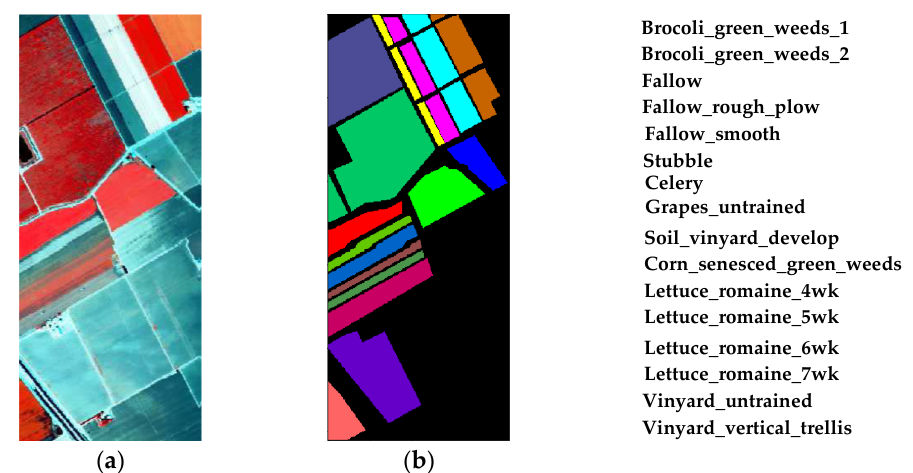
Figure 7. Salinas Data Set (( a ) False-color map; ( b ) Ground-truth map).